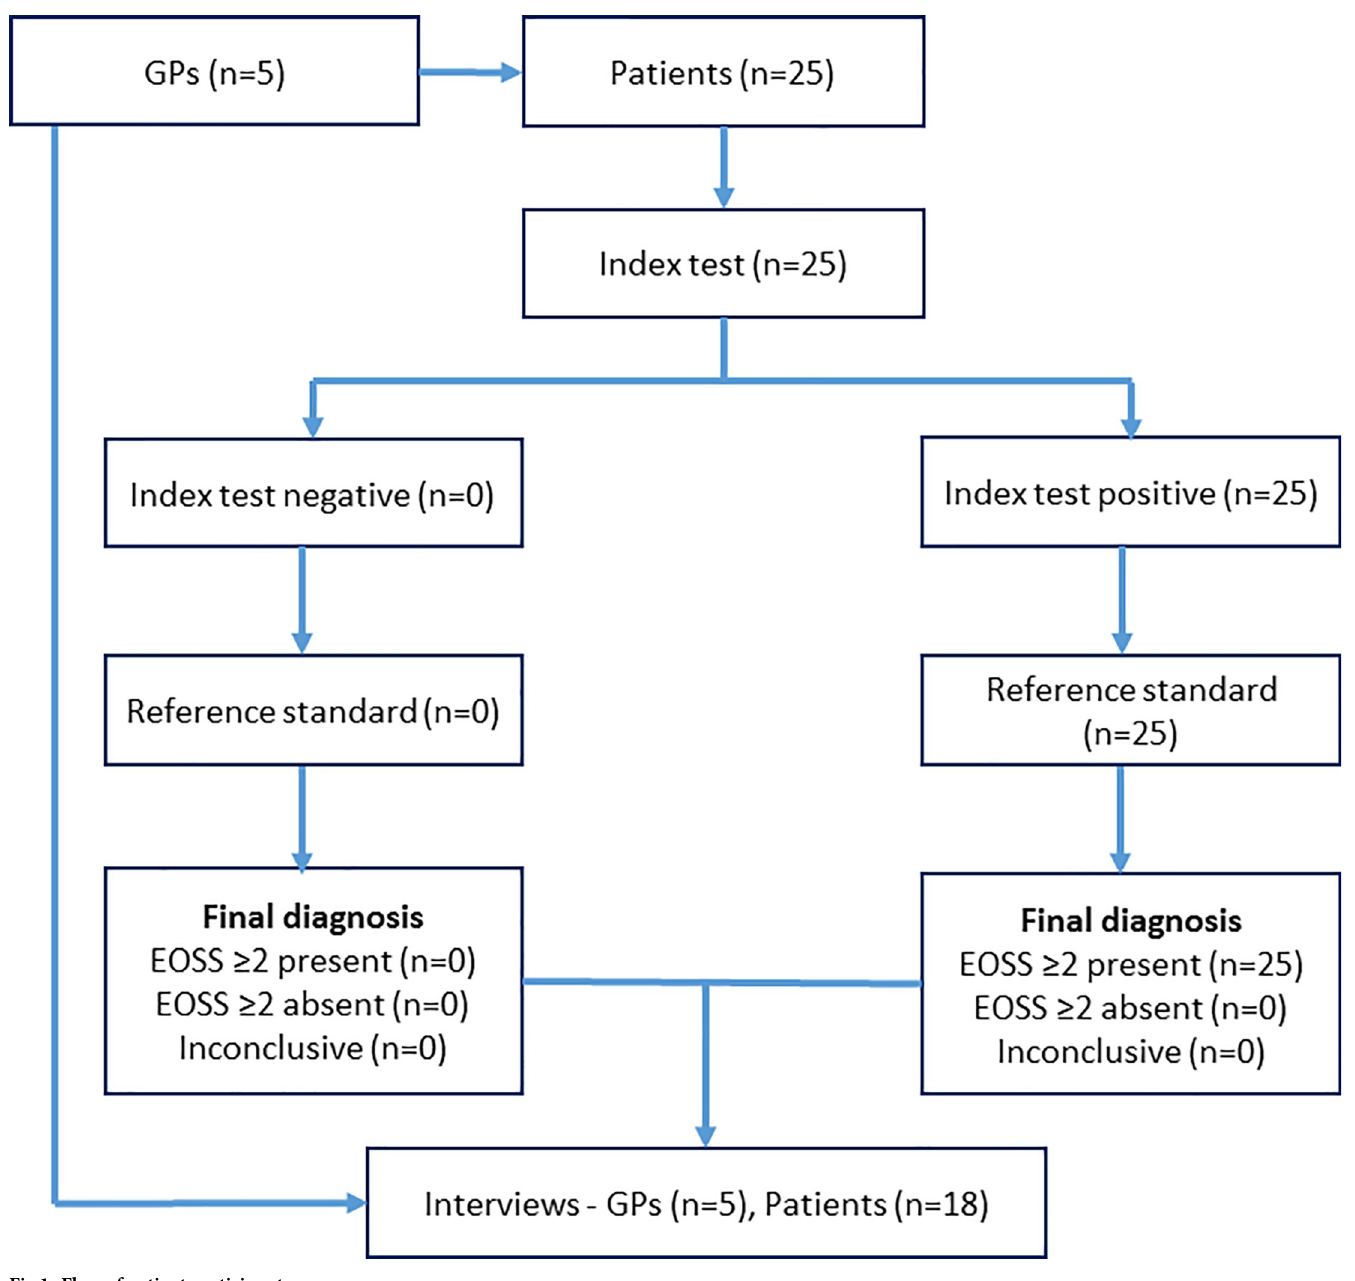
Fig 1. Flow of patient